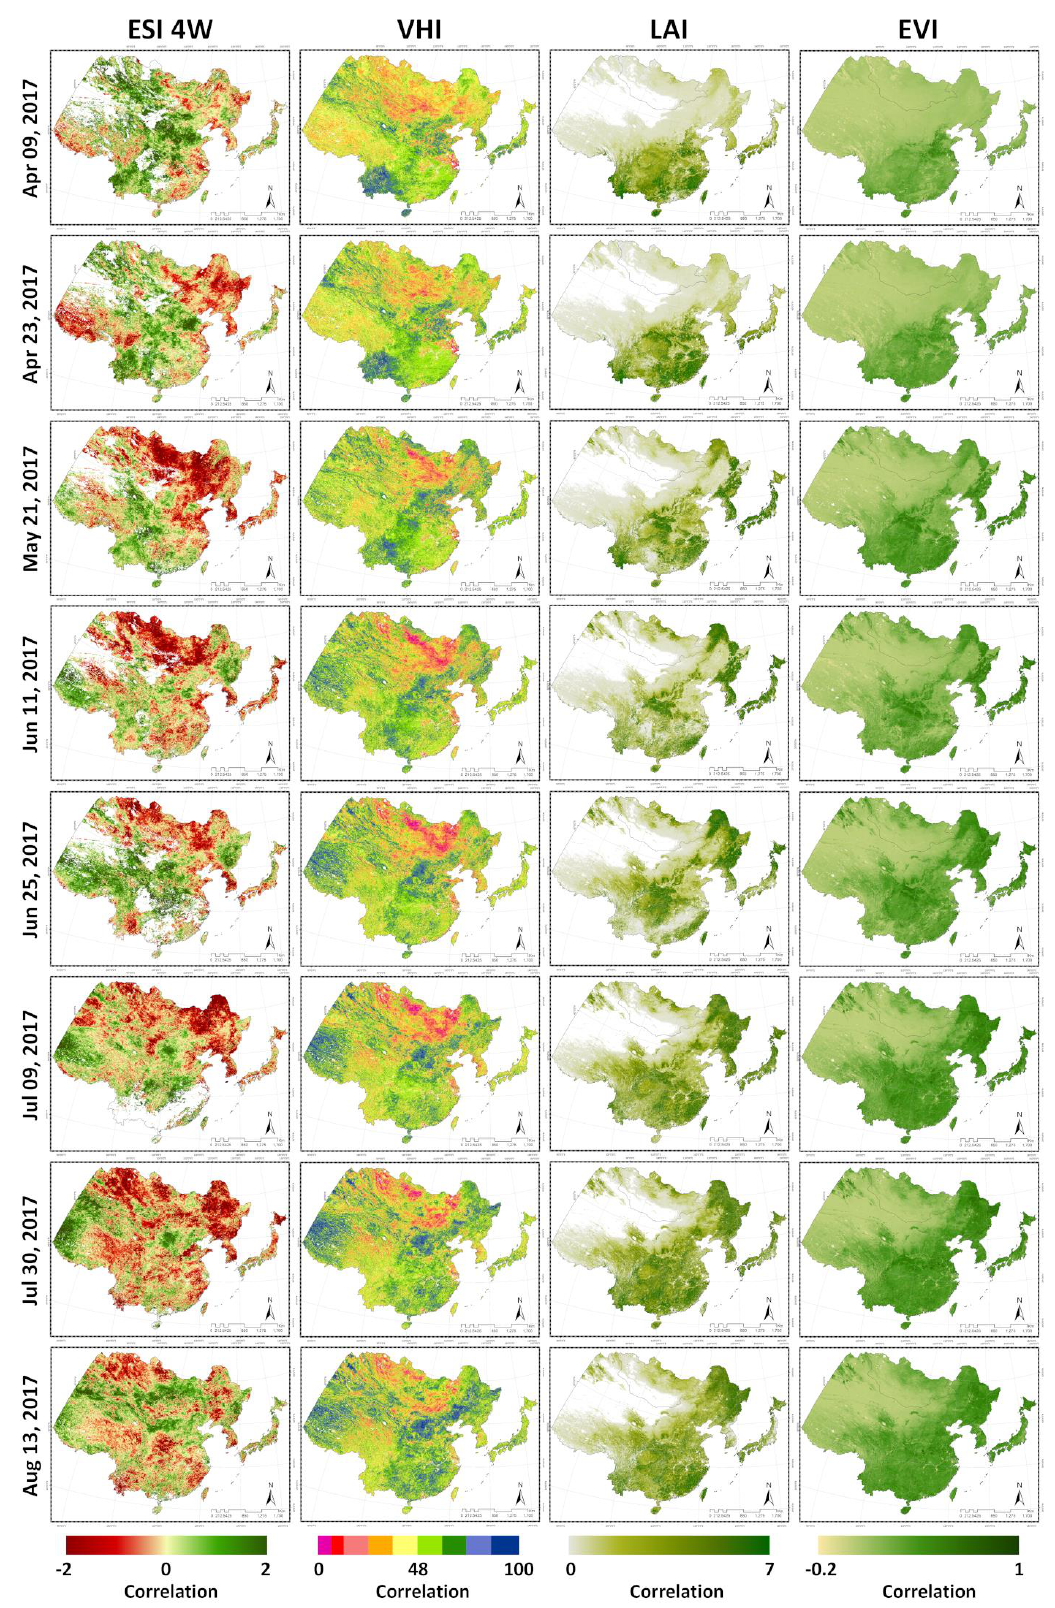
Figure 3. Comparison of trends for each drought index for China.